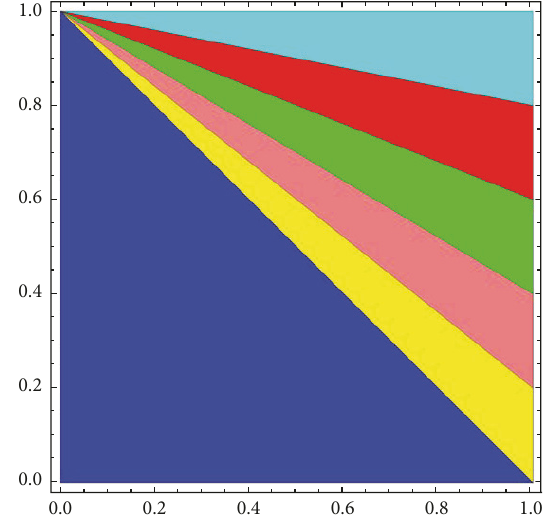
Figure 4: Region of 𝑥𝑦 plane where (41) holds true for 𝜃 = 0, 0.2, 0.4, 0.4, 0.6, 0.8, 1 represented by cyan, red, green, pink, yel- low, and blue colors, respectively.